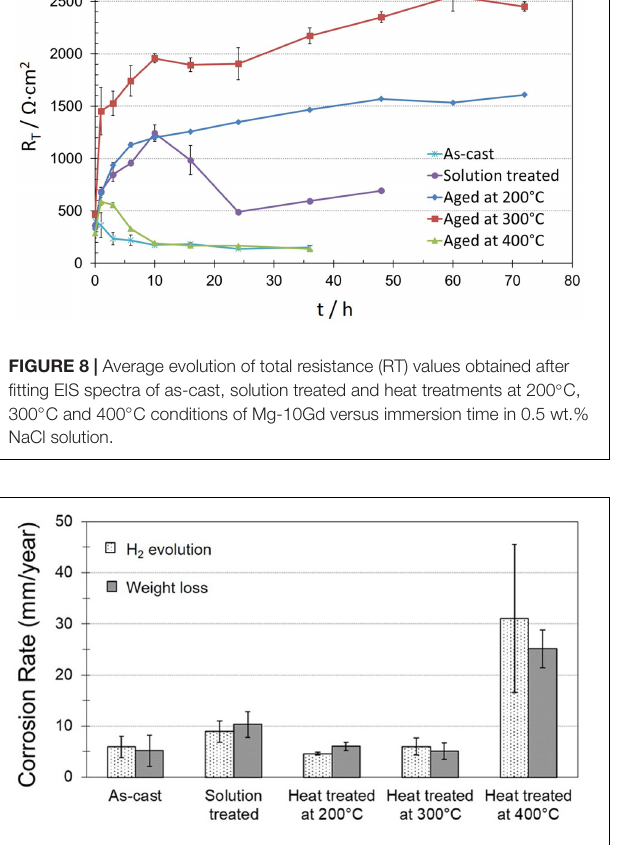
FIGURE 9 | Hydrogen evolution and weight loss of as-cast, solution treated and heat treated at 200 ◦ C, 300 ◦ C, and 400 ◦ C conditions of Mg-10Gd